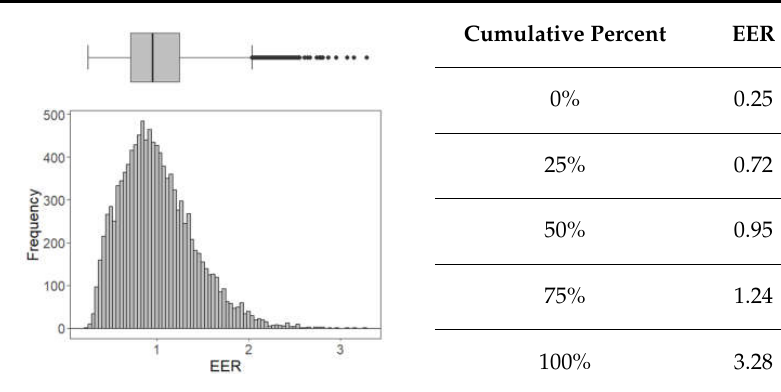
Table 10. Energy performance evaluation result of o ffi ce building.